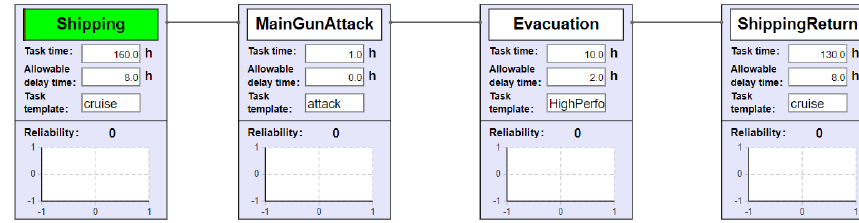
Figure 12. Task flow in the simulation system.